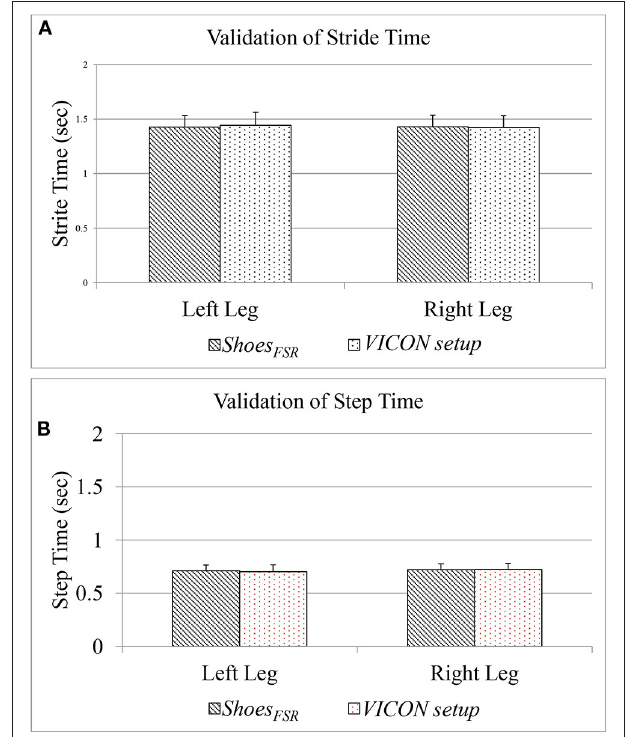
FIGURE 6 | (A) Comparison of Stride Time measured using Shoes FSR and VICON setup; (B) Comparison of Step Time measured using Shoes FSR and VICON